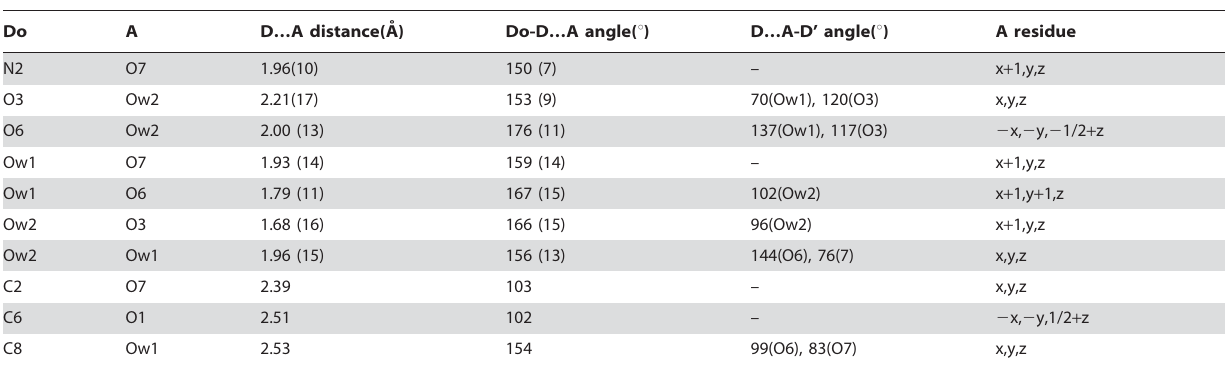
Table 1. Hydrogen bonding geometry.